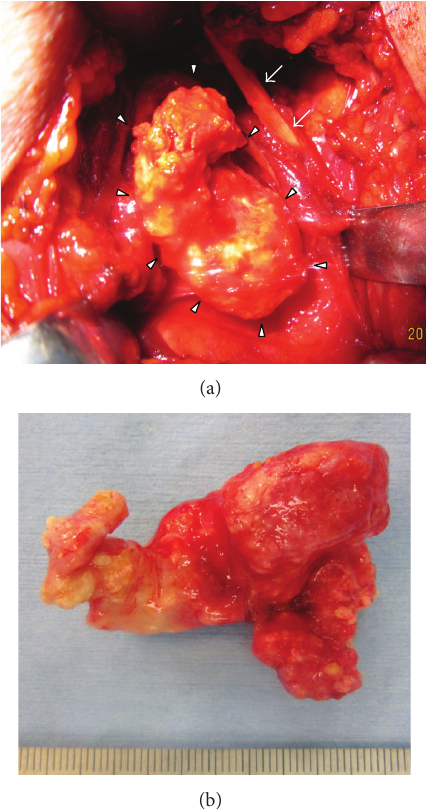
Figure 2: Operative findings. (a) Resection of the tumor (arrow- heads). Arrows indicate the posterior belly of the digastric muscle. There was no adhesion between the tumor and surrounding tissue. (b) Resected